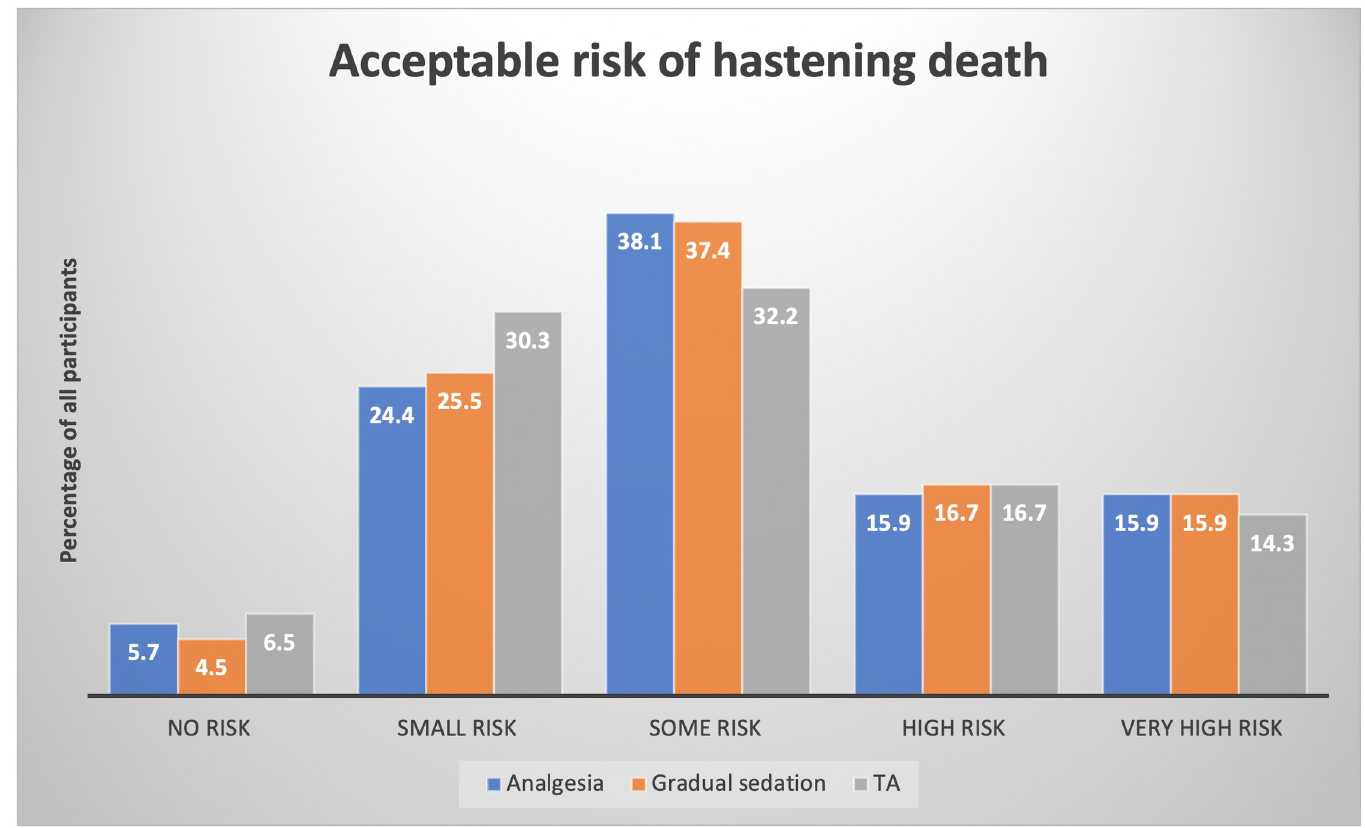
Fig 2. Views about the level of risk of hastening death that is acceptable when administering different end of life care options (n = 509).